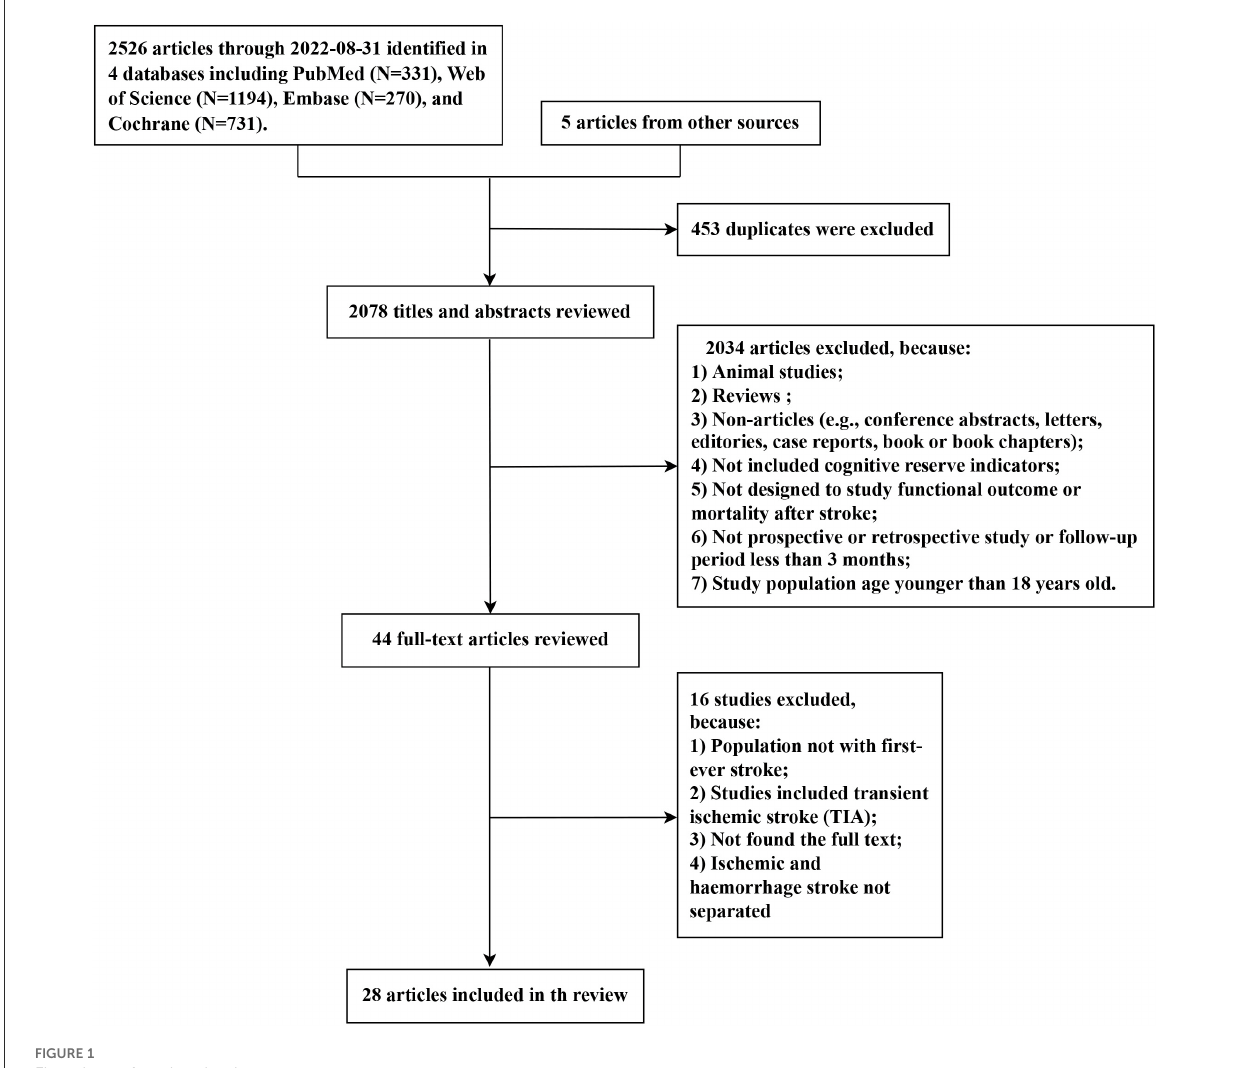
FIGURE1 Flowchart of study